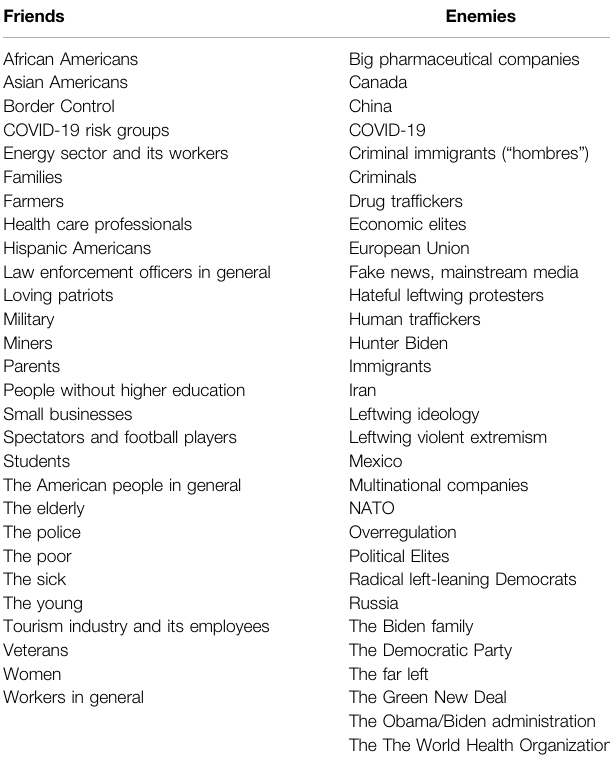
TABLE 3 | Trump ’ s categorization of political friends and